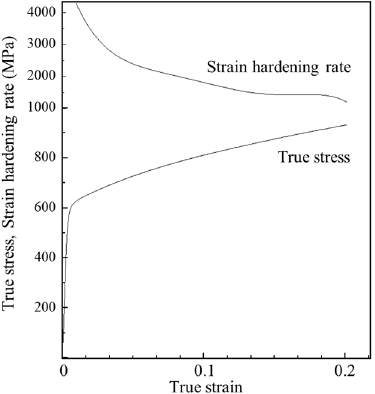
Figure 1. True tensile stress–strain curve up to 20% of strain.